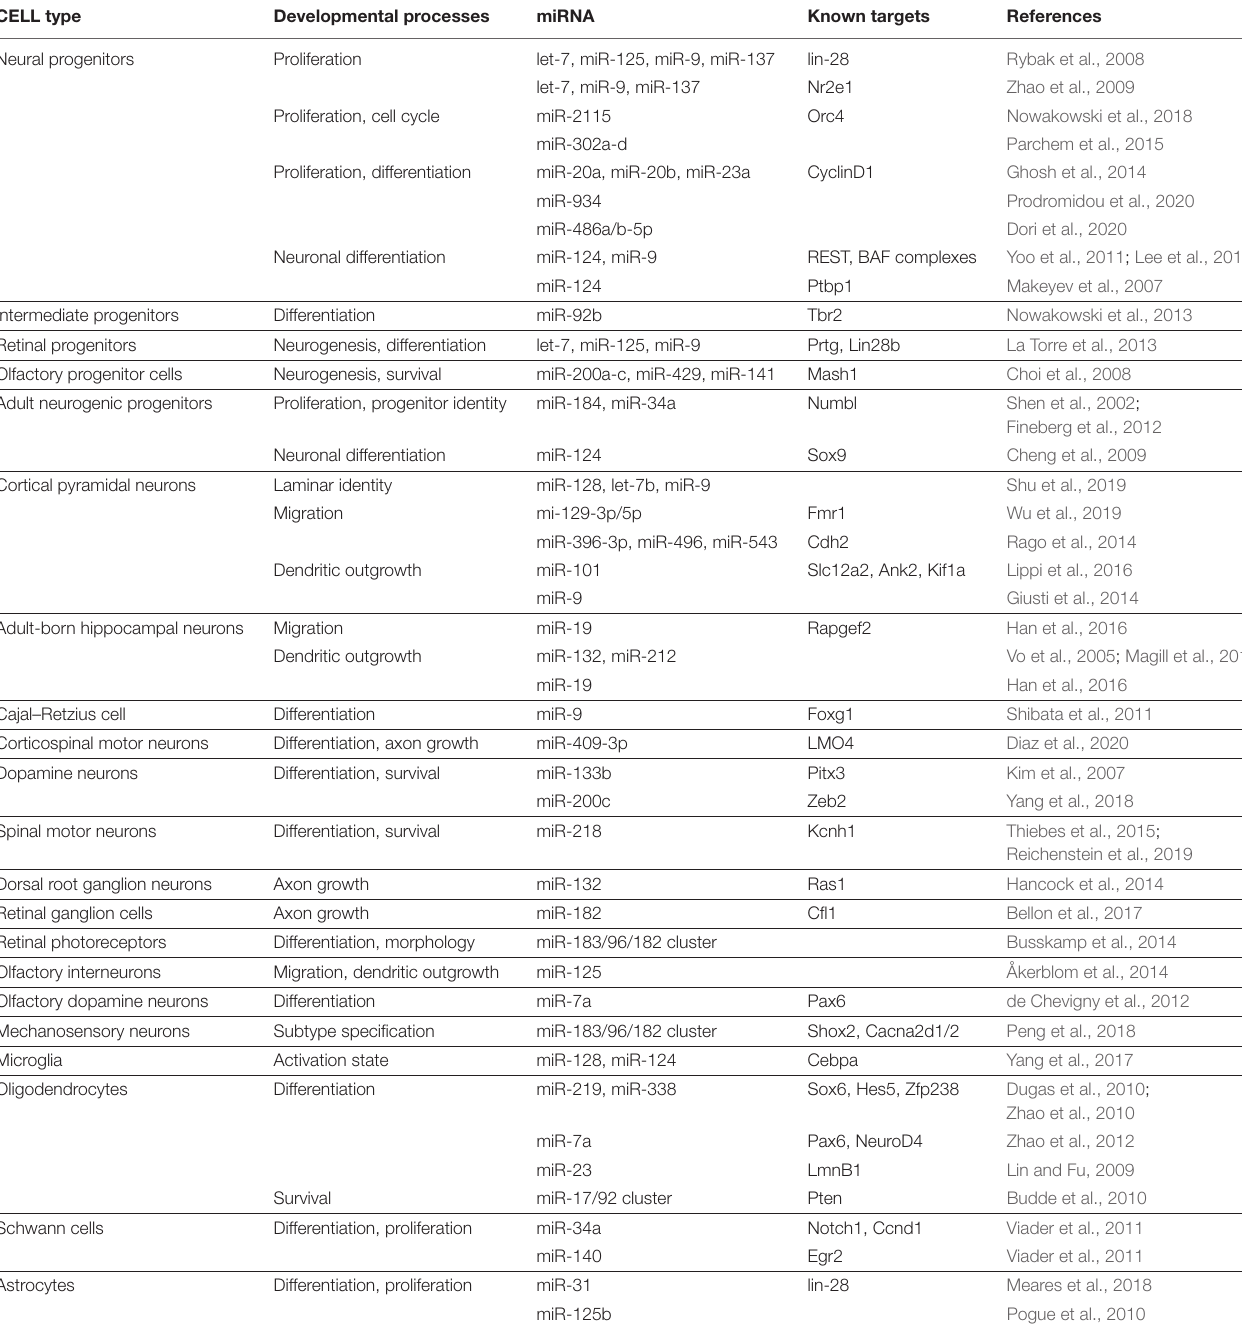
TABLE 1 | Summary of the most important miRNAs that instruct the identity of multiple cell types in the nervous